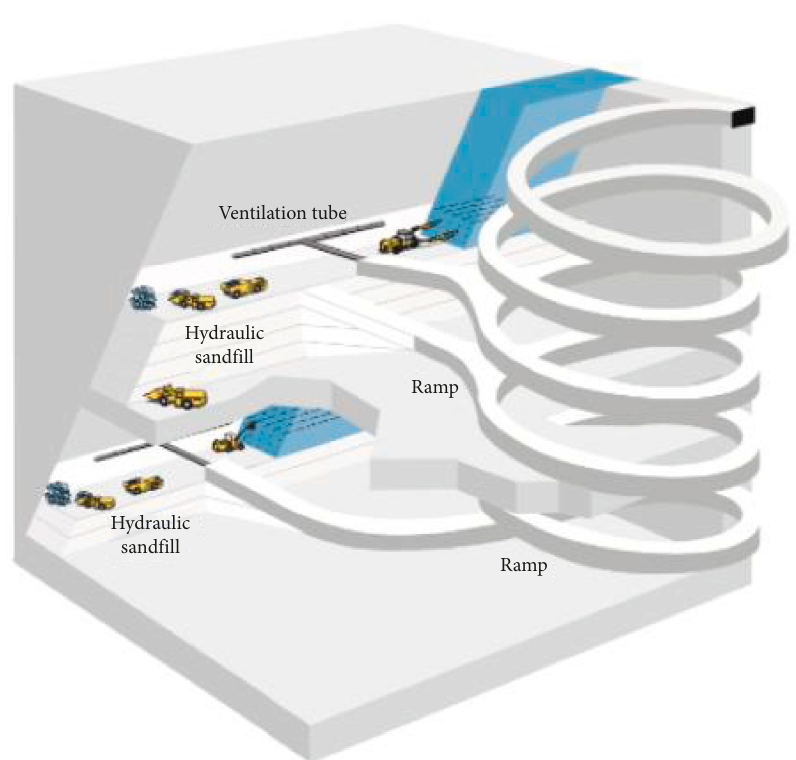
Figure 4: Cut and fill